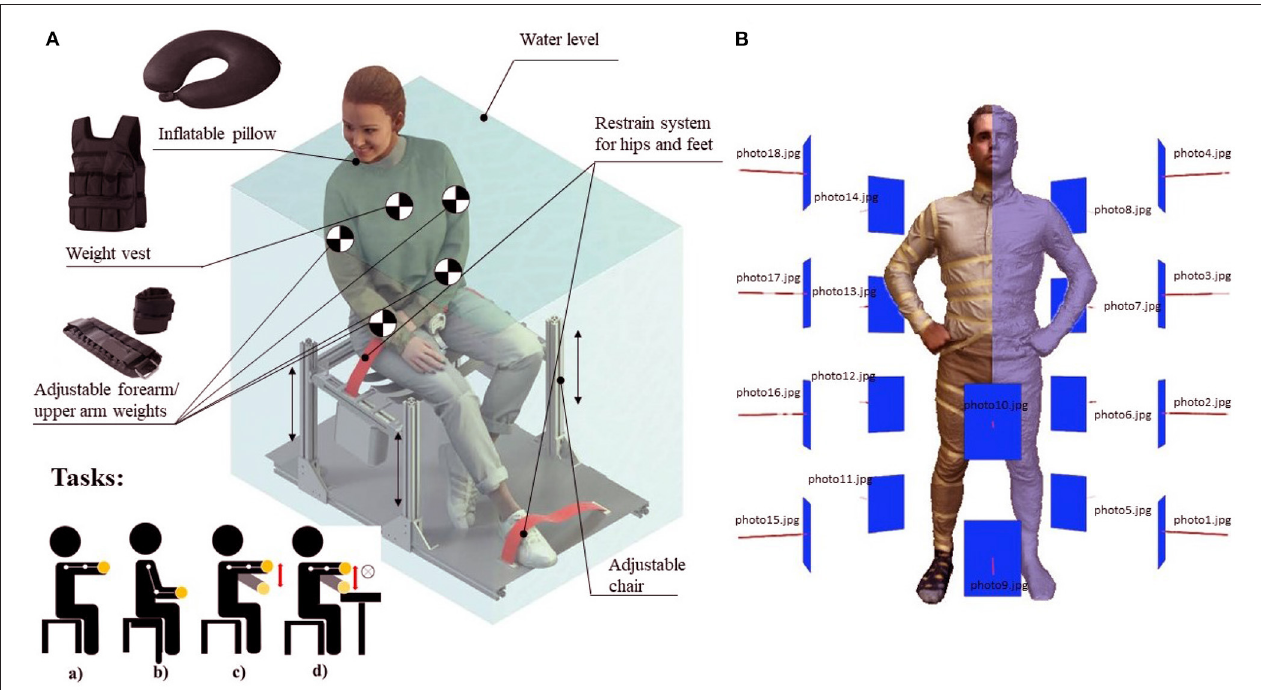
FIGURE 1 | (A) Technical aspects of experimental setup. Tasks: a) Holding weight with an outstretched arm, Task (S1); b) Holding weights in an arm bent at the elbow, Task (S2); c) Slow 1 (lifting)-2 (lowering)-1-2 hand motion with weight (3 sec range of motion), Task (D); d) Repetitive motion with load 1(lifting)-2 (horizontal transfer)-3 (lowering)-4 (pause without load)-1-2-3-4 with constant repetition, Task (R). Image from: open source model https:/humano3D.com. (B) Participants 3D scan example with a visual explanation of the principle of photogrammetry (Agisoft Metashape).